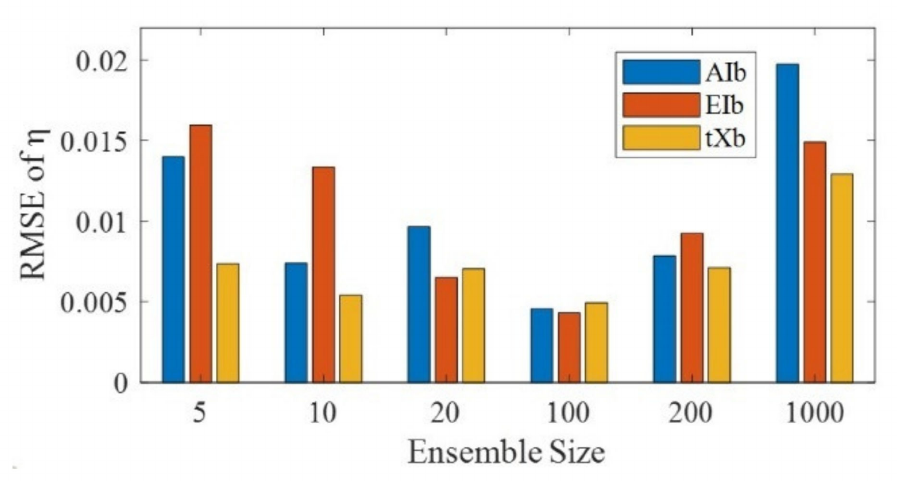
Figure 6. Mean RMSE of η in the last 5000 TUs of different ensemble sizes in the perfect model with AIb (blue bar), EIb (orange bar) and tXb (yellow